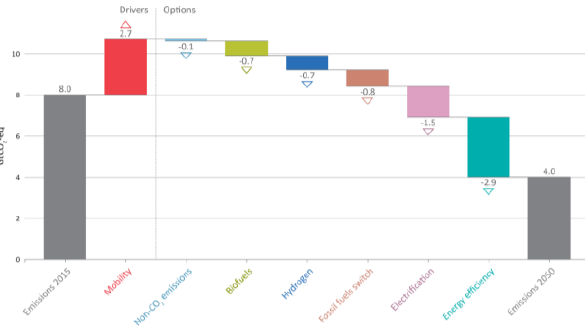
Fig. 2. Transport GHG mitigation options from 2015 to 2050, central 2°C scenario, world, in billion tonnes of CO 2 equivalent (GtCO 2-eq ). Source: POLES-JRC 2018 (Keramidas et al.,